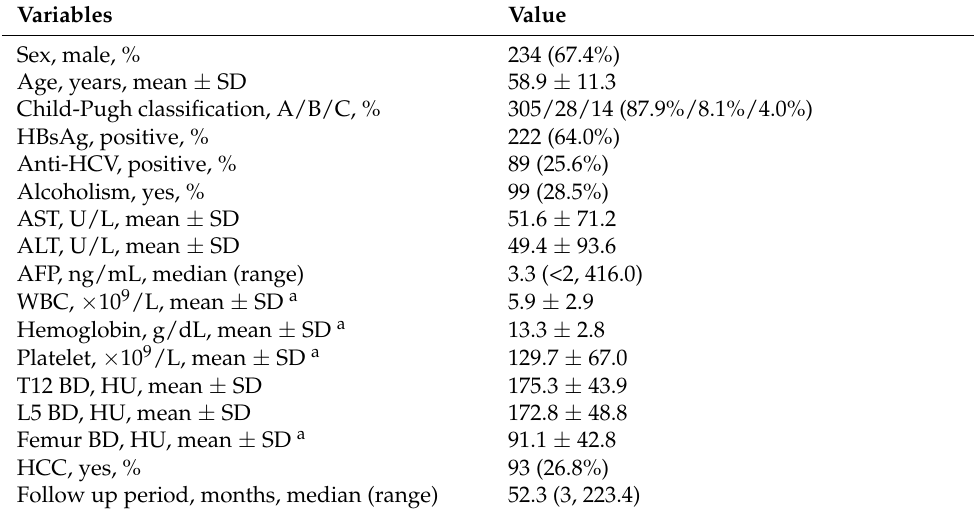
Table 1. Baseline clinical data for 347 cirrhotic patients with CT scan